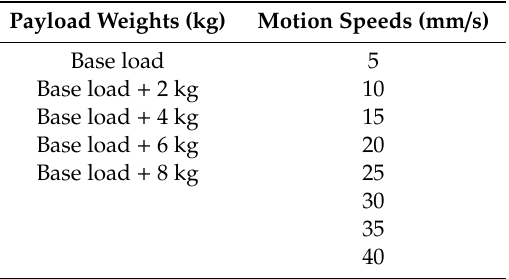
Table 8. CNC testing parameters.